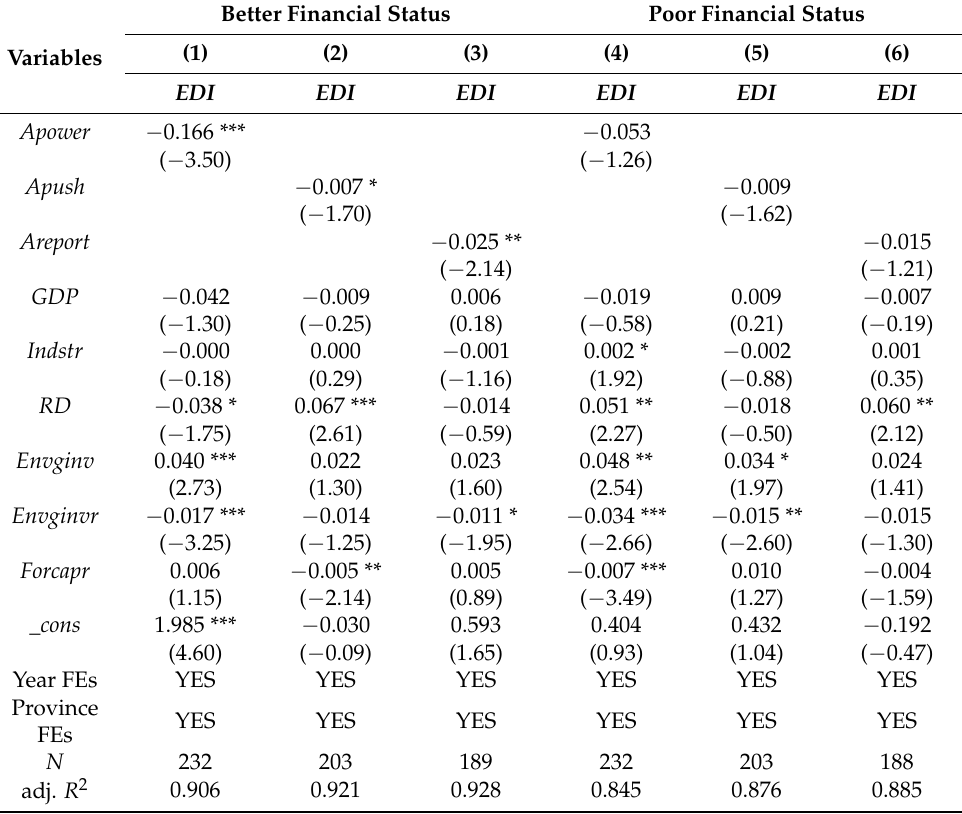
Table 7. Government environmental auditing, financial status, and environmental quality. Better Financial Status Poor Financial Status Variables